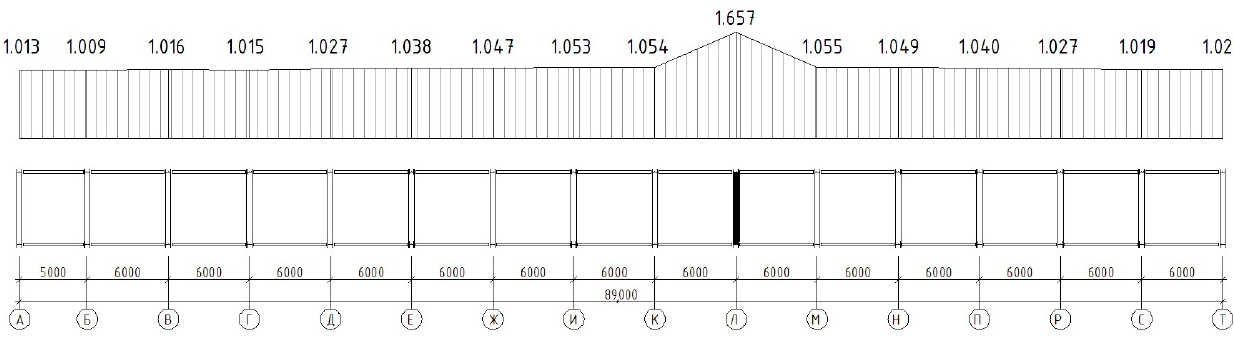
Figure 24. Diagram of the distribution of the dynamic coefficient in case of damage of the lower chord.